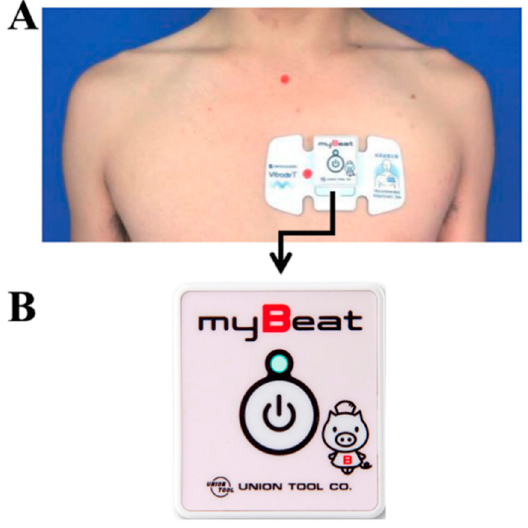
Figure 2. Wearable WHS-1 and electrode on the anterior chest. ( A ) Location of lead on the anterior chest. ( B ) Wearable WHS-1 apparatus.